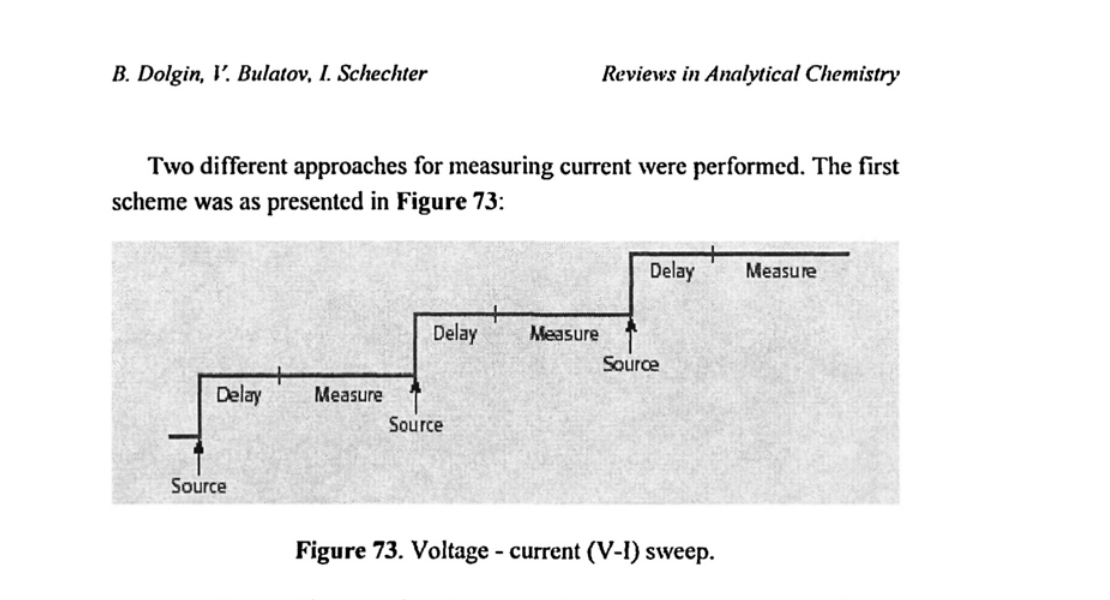
Figure 73. Voltage - current (V-I)